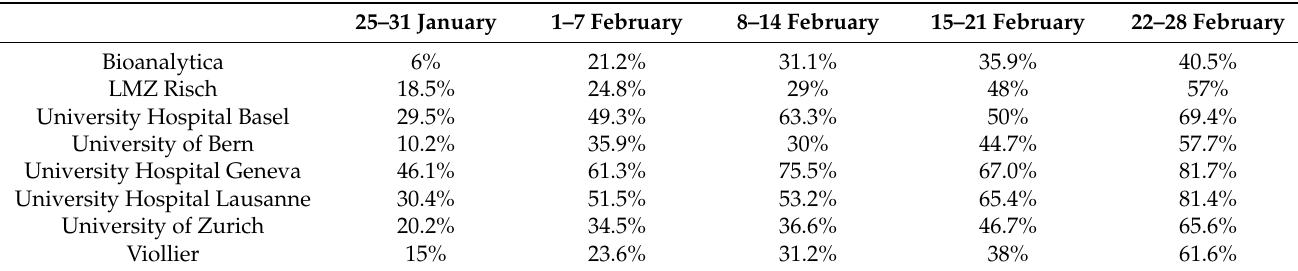
Table 2. Relative proportions of N501Y of total detected positive cases. This table shows the relative detection rate of the N501Y positive variants according to